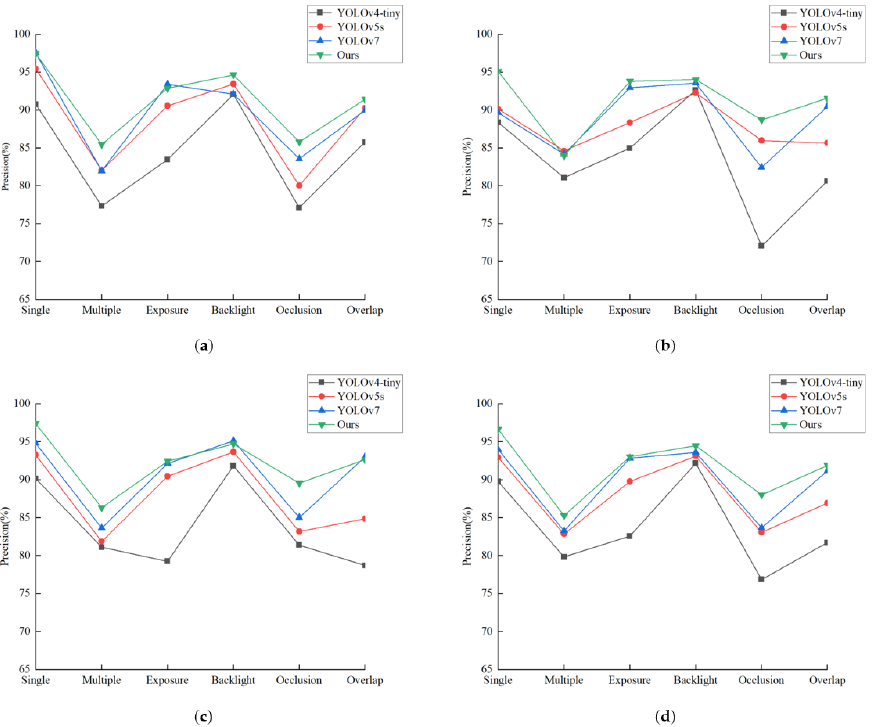
Figure 13. Comparison of the detection performance of the four models in different field environ- ments. ( a ) Detection precision of unripe pineapples; ( b ) Detection precision of semi-ripe pineapples; ( c ) Detection precision of ripe pineapples; ( d ) Average detection of pineapples.